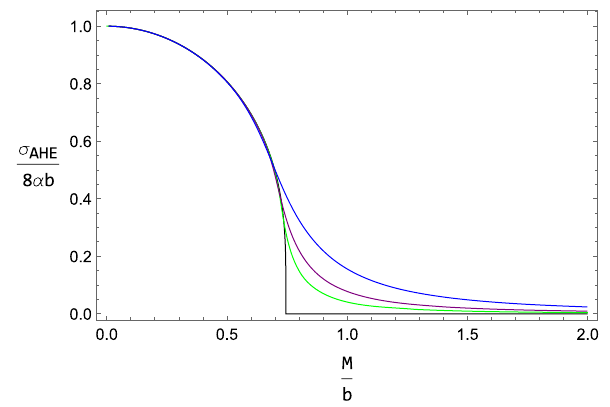
Fig. 1 The anomalous Hall conductivity as a function of the M / b in the minimal holographic Weyl semimetals [12]. The black line corre- sponds to the zero temperature while the colored lines correspond to the finite temperature with T / b = 0 . 05 (blue), 0 . 03 (purple), 0 . 02 (green) respectively. At finite temperature, the sharp quantum phase transition becomes a